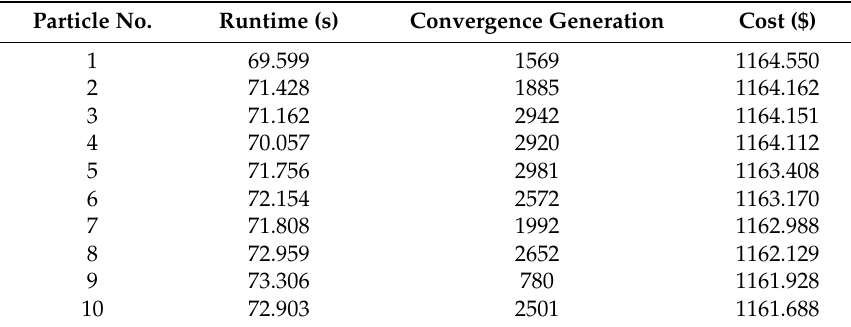
Table 1. Numerical Results by the iSSO